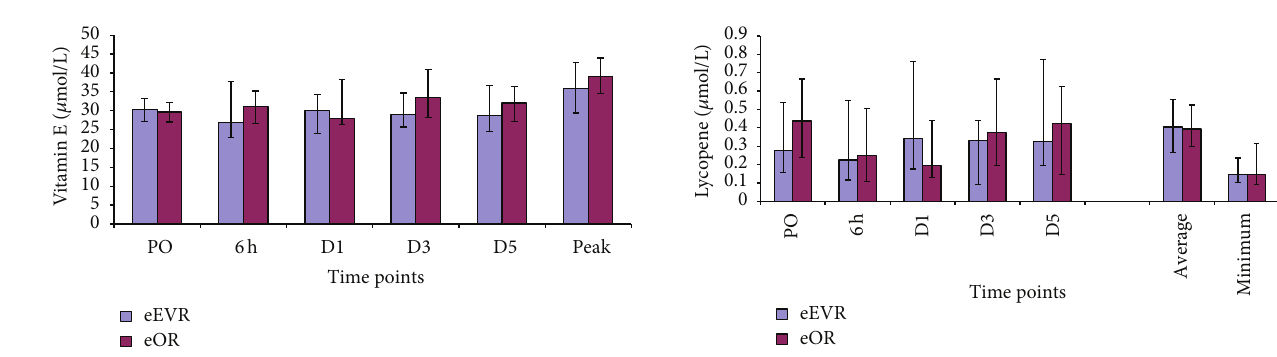
as the intestinal manipulation, exposure of the abdominal viscera, mesenteric traction, and lower limb ischemia-reper- fusion injury in the eOR group [20]. The peak of IL-6 at 24 hours occurs also in elective repair, with less in EVAR [21].